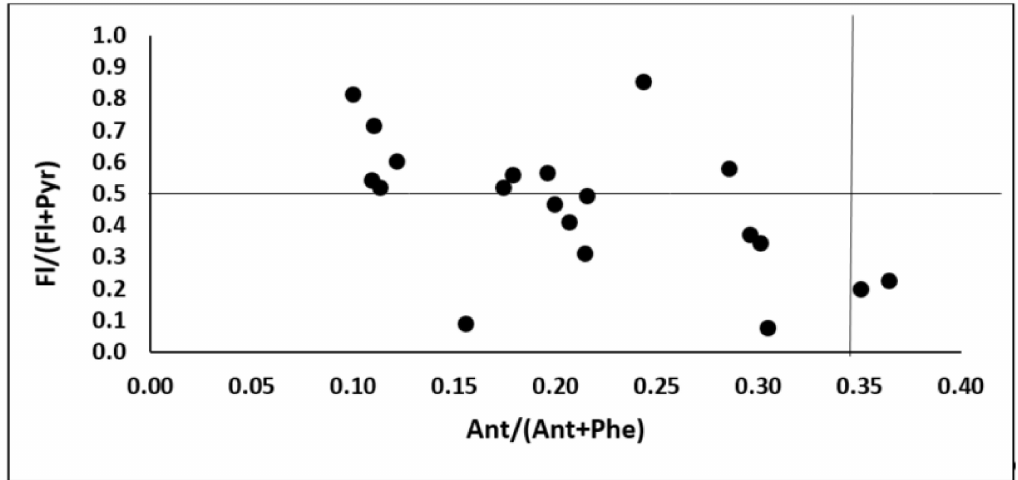
Figure 1. The PAHs diagnostic ratios for identification the source of soil